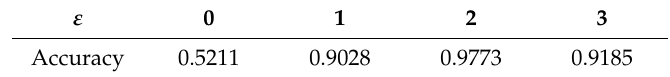
Figure 11. Performance of our human detection and flow estimation approach on our dataset with 97.73% AP and 40 fps. Table 8. The flow estimation performance with different punish parameter ε .